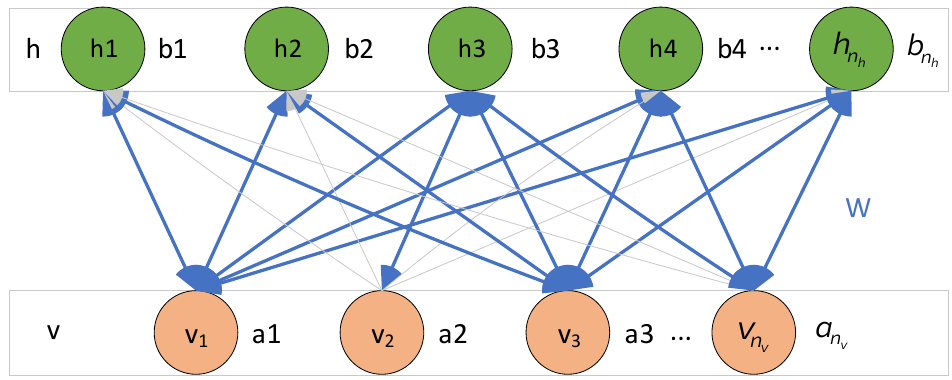
Figure 2. The restricted Boltzmann machine (RBM)